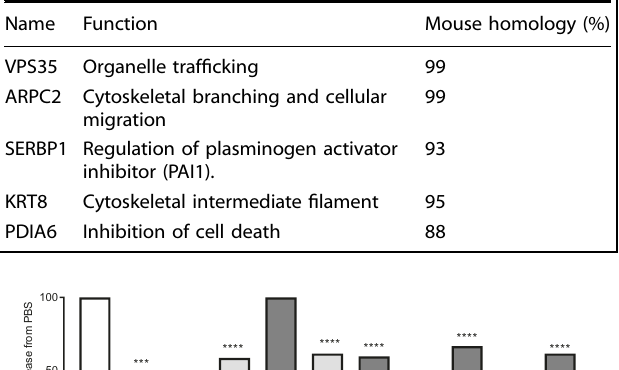
Table 1. Homology and function of selected antigens.